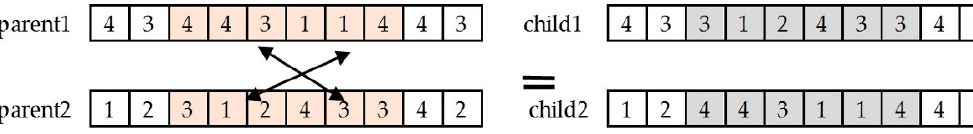
Figure 5. Crossover operator for sharing information among worker bees. An example of two worker bees (parent1 and parent2) exchange index of points (orange) to generate new worker bees (child1 and child2; gray).